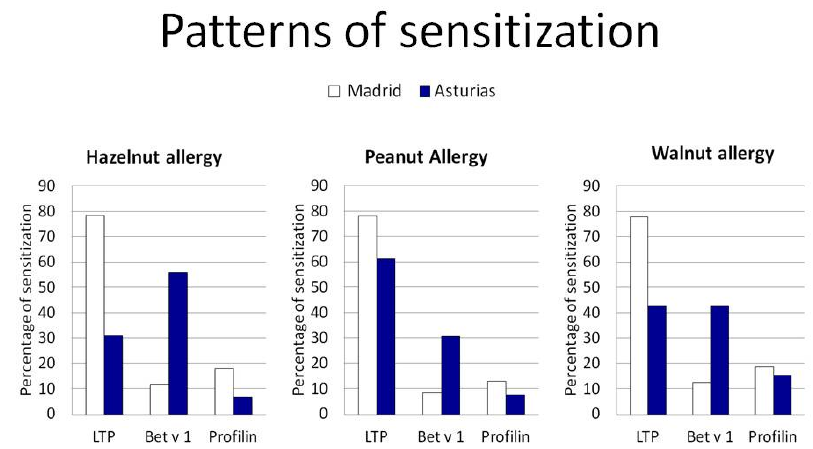
Figure 3. Differences in molecular pattern between Madrid and Asturias for patients allergic to hazelnut, peanut, or walnut.